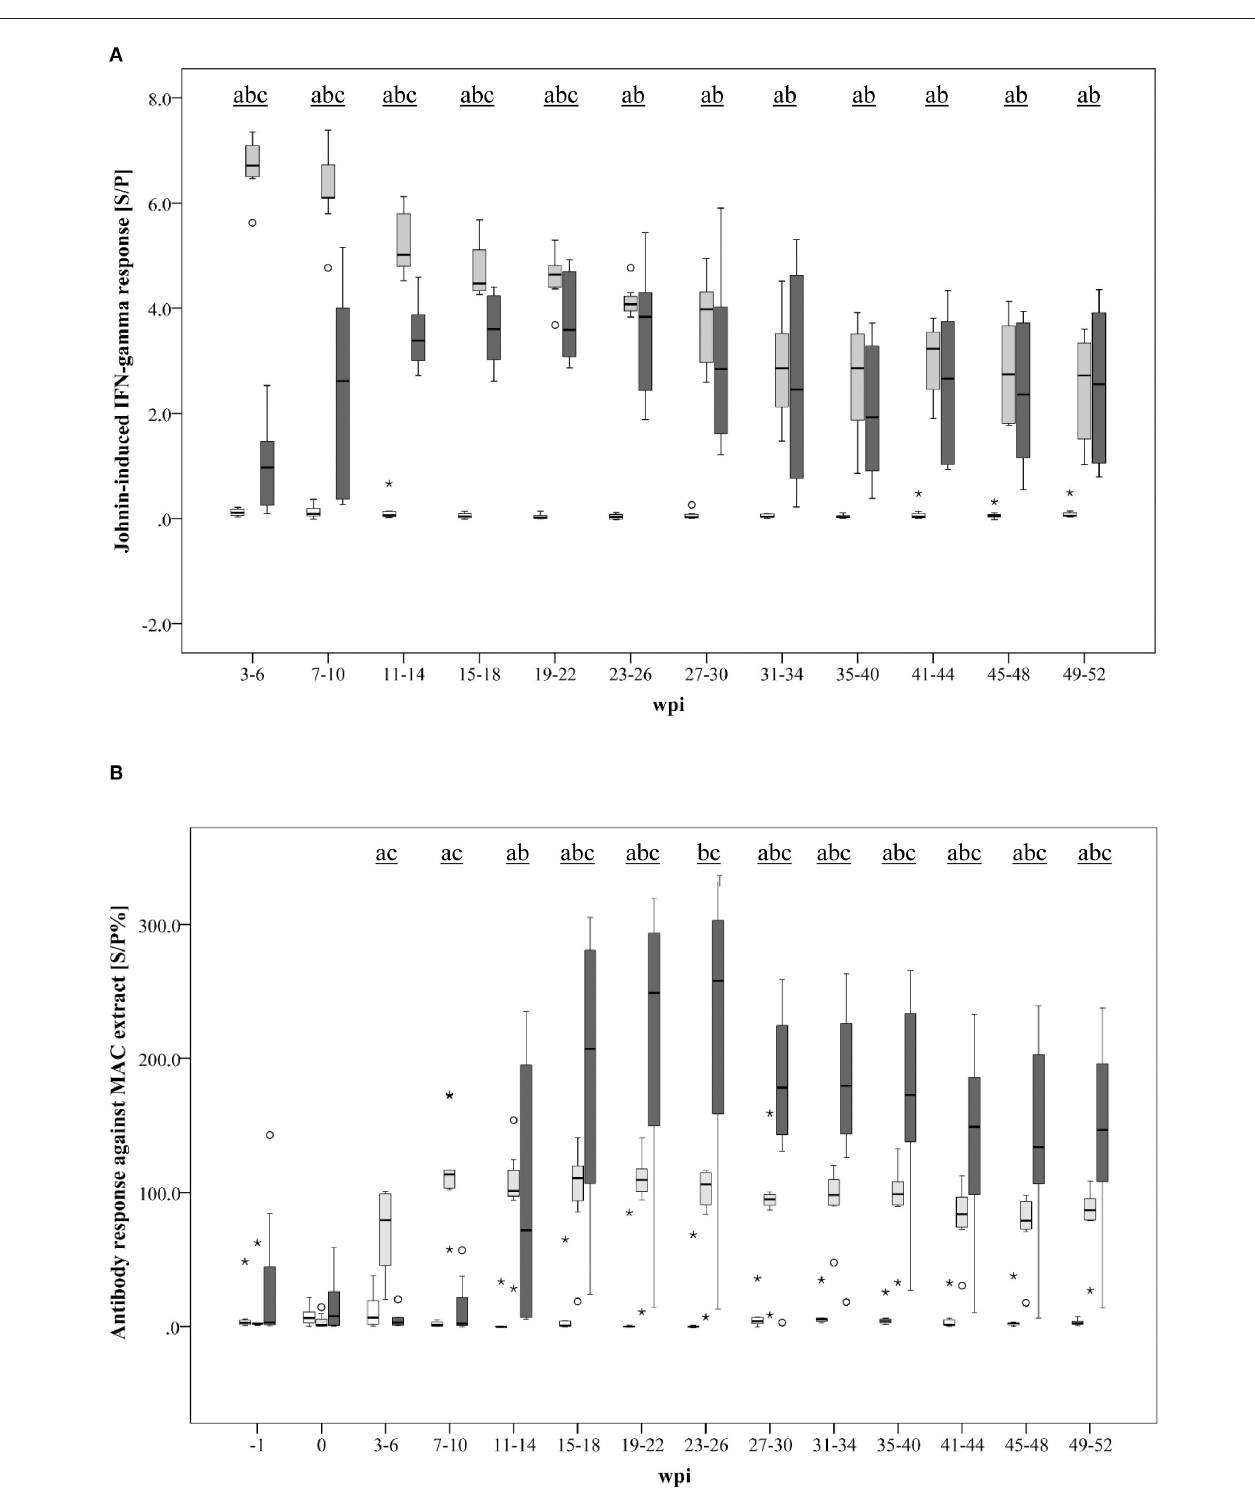
FIGURE 3 | (A, B) Kinetics of the specific immune response of MAH and MAP-inoculated goats vs. non-infected control goats. (A) PPDj-induced whole blood IFN- response [S/P]; (B) serum antibody response against a MAC extract containing common antigens of MAH and MAP measured by ELISA [S/P%]. Box and Whisker Plot represents median value, 25% and 75% percentiles (box), range, outlier values ( (cid:4) ), and extreme values (*). Groups: control, MAH, MAP. Different letters indicate significant differences between the groups: a - control vs MAH, b - control vs MAP, c - MAH vs MAP (Tukey-Kramer post hoc test, P < 0.05).